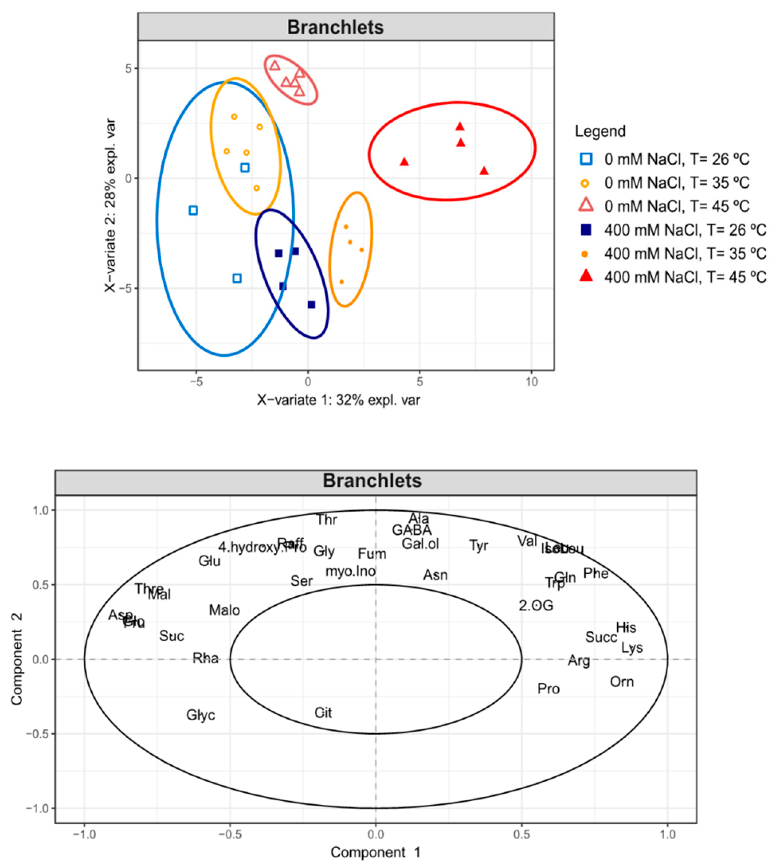
Figure 7. Partial least square discriminant analysis (PLS-DA) score and loading plot in the branchlets of C. glauca plants under the single and combined exposure to salt (0 and 400 mM NaCl) and temperature (26, 35 and 45 °C) conditions.